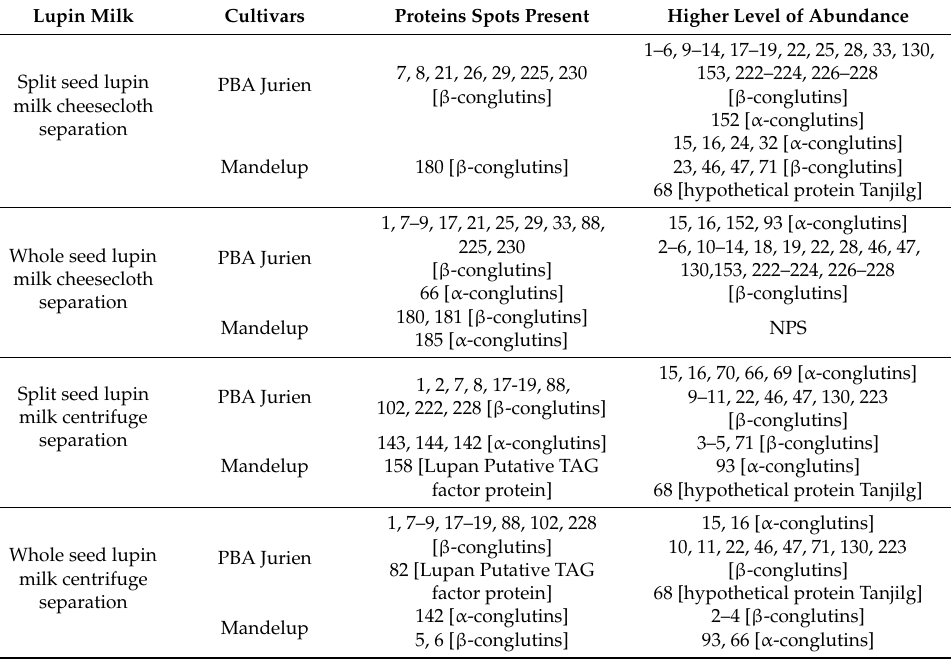
Table 5. List of the lupin proteins compared between PBA Jurien and Mandelup cultivars with respect to protein spots and their